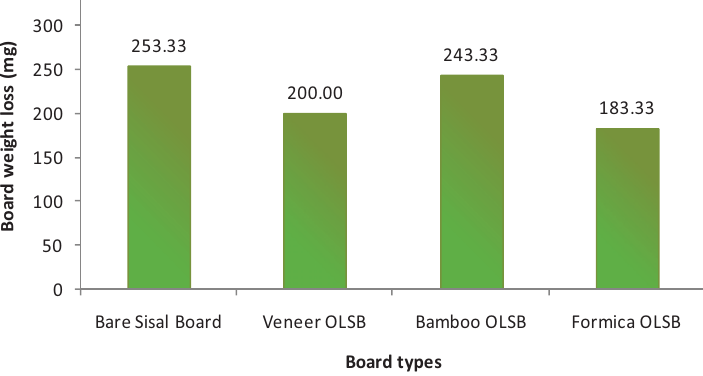
Figure 2. Mean mass loss in mg of bare and overlaid sisal fiberboards. OLSB: overlaid sisal fiberboard.